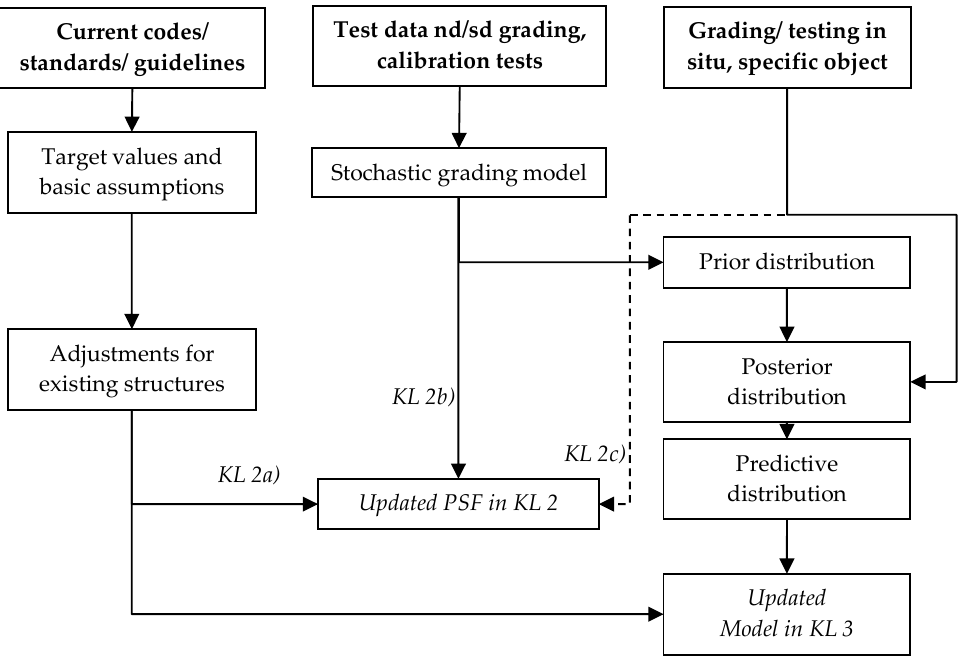
Figure 5. Considering different sources of information.